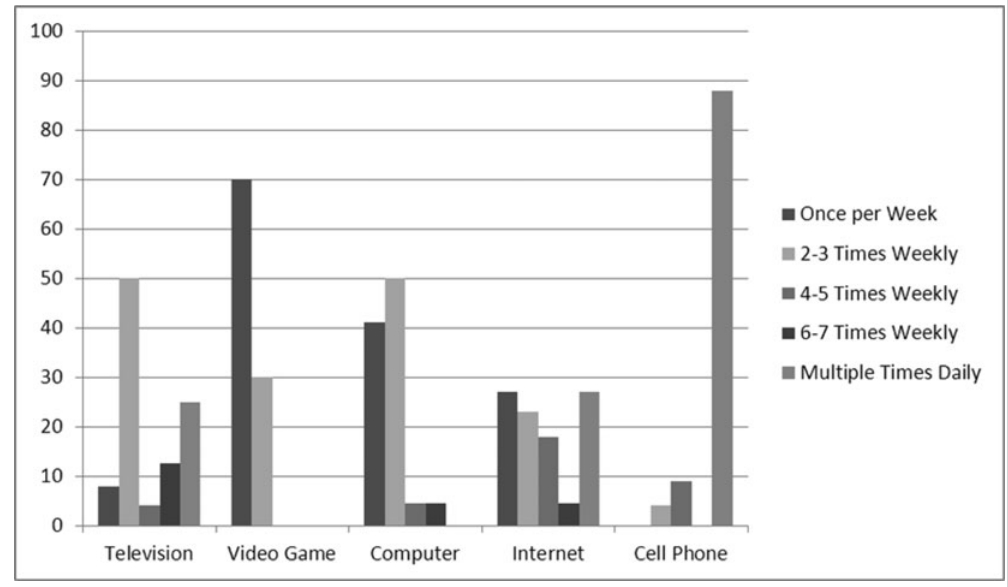
Percentage (valid) of indigenous adolescents selecting each response-option for frequency of use of each small screen technology.